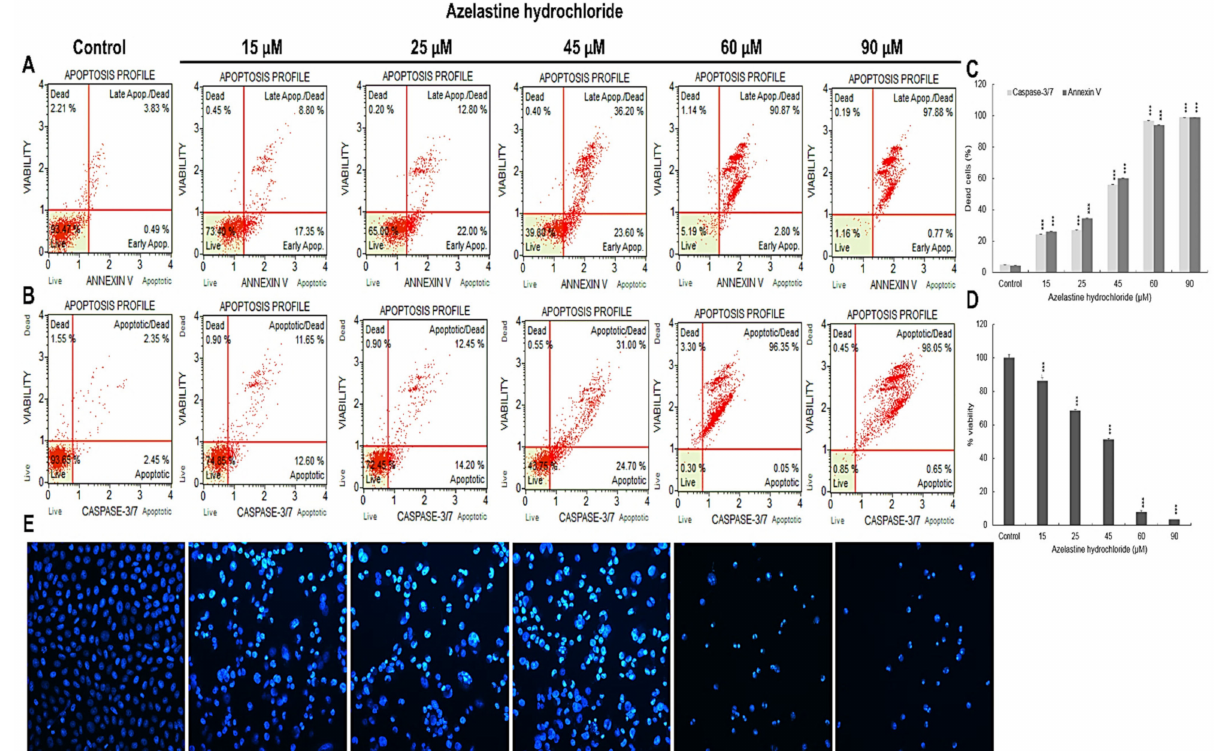
Figure 1. Proapoptotic effects of azelastine hydrochloride. Control cells and treated for 48 h with azelastine at concentrations of 15 µ M, 25 µ M, 45 µ M, 60 µ M, and 90 µ M. ( A ) Level of